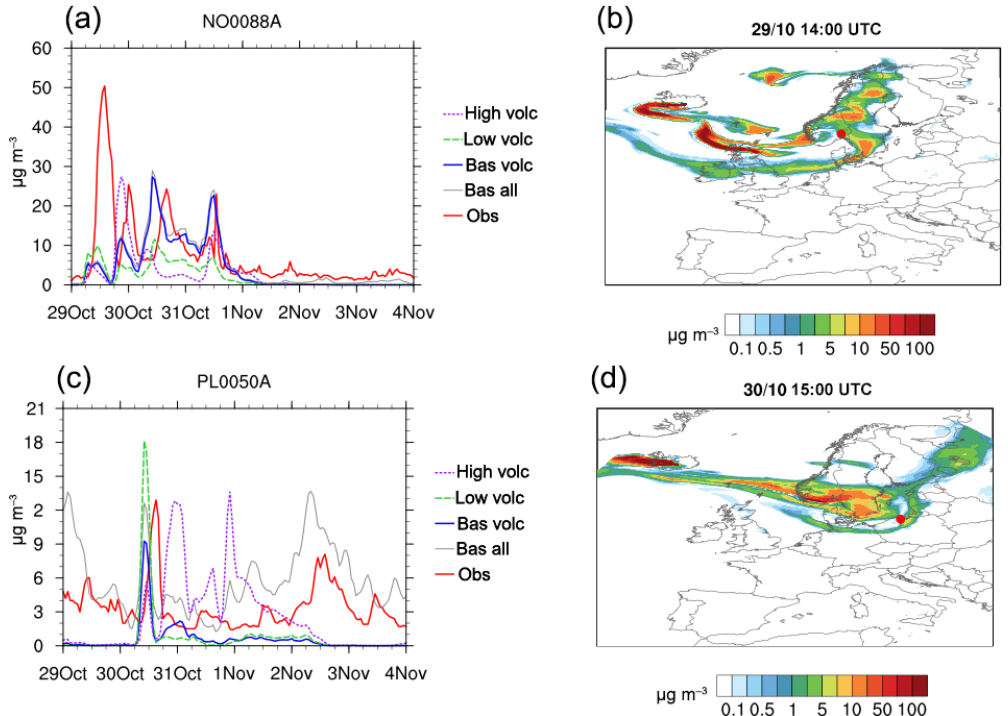
Figure 6. The same as Fig. 4 but from 29 October to 4 November 2014 for NO0088A Oslo, Norway and PL0050A in Sopot Poland, both SO 2 . Table 2. Emissions, depositions and concentrations for the 28 European Union member states, Norway and Switzerland for the 3 months September, October, November 2014; emissions and depositions are totalled over the 3 month period, concentrations are the mean over the period for the 31 countries. Numbers in brackets are the contribution from Iceland, for emission and deposition. For concentrations, the number represents the average over Iceland. See simulation names and set-up in Table 1. Simulations: no_hol bas_hol low_hol high_hol